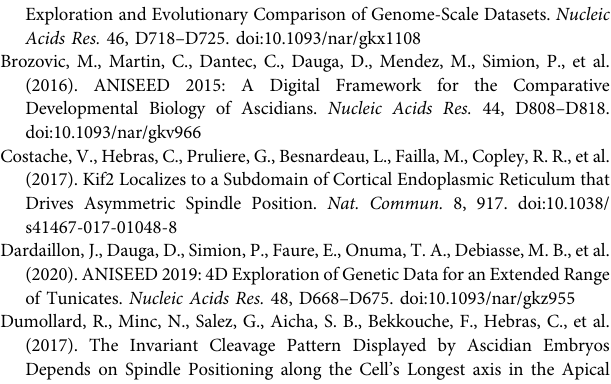
Supplementary Figure 1 | Early embryonic development of A. aspersa. Scale bar: 50 μ m. Supplementary Figure 2 | Relationships between the time after fertilization and developmental stage in A. aspersa (20 ° C) and C. intestinalis type A. Developmental time course plot of Ascidiella aspersa embryos and larvae at 20 ° C. Supplementary Figure 3 | Ca 2+ dynamics of an inseminated egg of A. aspersa . Images were collected every 1 s using fl uorescent microscopy and displayed every 3 s in this fi gure. Two series of Ca 2+ transients were observed immediately after fertilization. (A) First phase of Ca 2+ dynamics. The Ca 2+ increase propagated from the place indicated by an arrowhead. pb, polar body. (B) Second phase of Ca 2+ dynamics. (C) The change of relative fl uorescence intensity of GCaMP6s during Phase I and Phase II of fertilization. Supplementary Movie 1 | Time-lapse movie of A. aspersa development at 20 ° C. Supplementary Movie 2 | Three-dimensional timelapse imaging of A. aspersa embryodevelopment.TheplasmamembranewasstainedwithFM4-64.Imagesare acquired by using 40 × oil immersion lens, 559 nm excitation. Every z-stack image (consists of 22) with 3-µm intervals were taken every 3 s. Different embryo images from 32-cell stage to early tailbud stage were